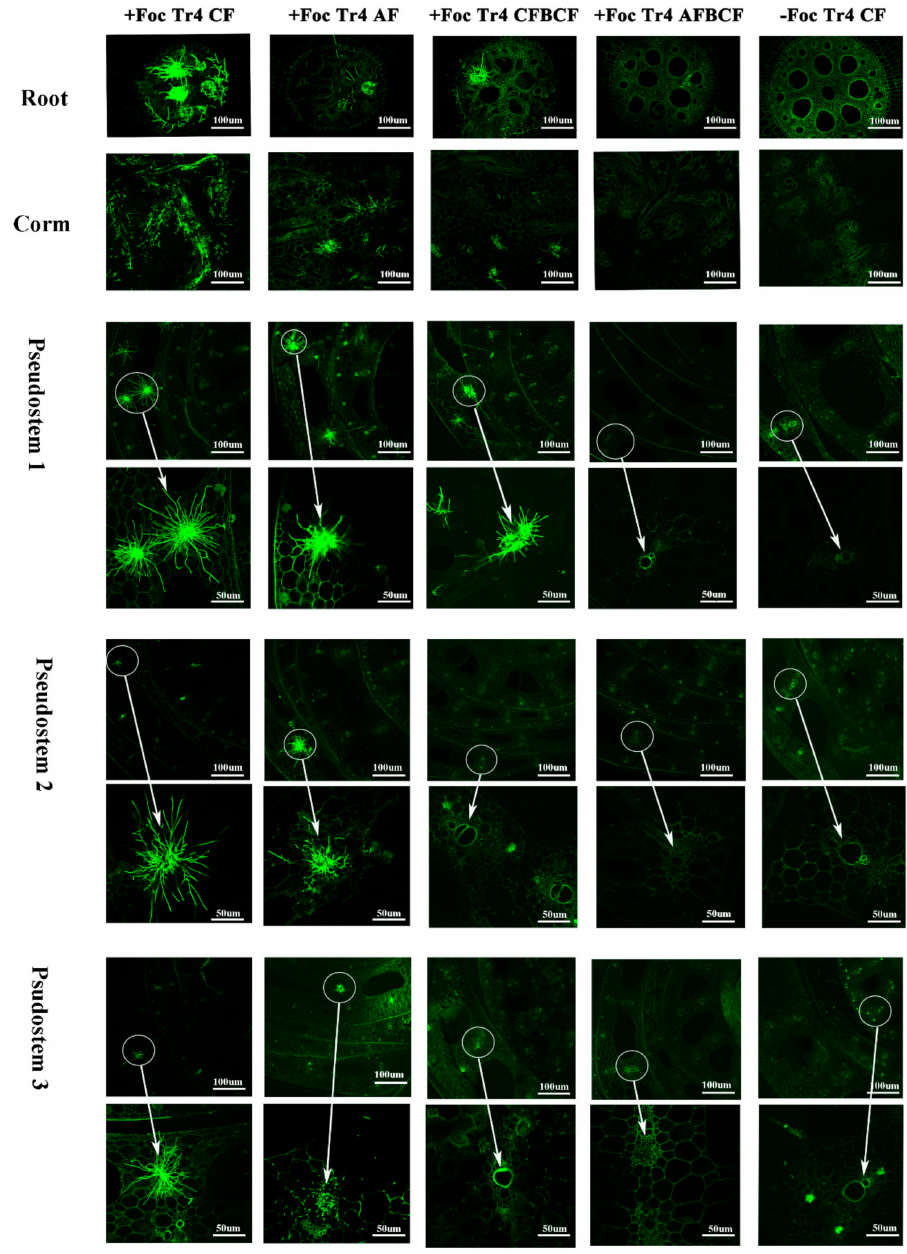
Figure 8. Expansion and colonization of GFP-tagged Foc Tr4 pathogen in banana in roots, rhizomes and pseudostem. Roots, rhizomes, and pseudostems were observed in cross sections. Pseudostems 1, 2, and 3 represented the pseudostem from rhizome to the first leaf, the first leaf to the second leaf and the second leaf to the third leaf count backwards, respectively. The electron microscope image indicated by the arrow is a fivefold magnification of the pathogen in the circle; The typical fluorescence image of Foc Tr4 pathogen in bananas is shown in the left column of Figure 8. The obvious hyphae colony image was the Foc Tr4 pathogen and the others were the plants’ own fluorescence. CF stands for conventional fertilizer. AF stands for alkaline fertilizer. CFBCF stands for conventional fertilizer and biocontrol fungi. AFBCF stands for alkaline fertilizer and biocontrol